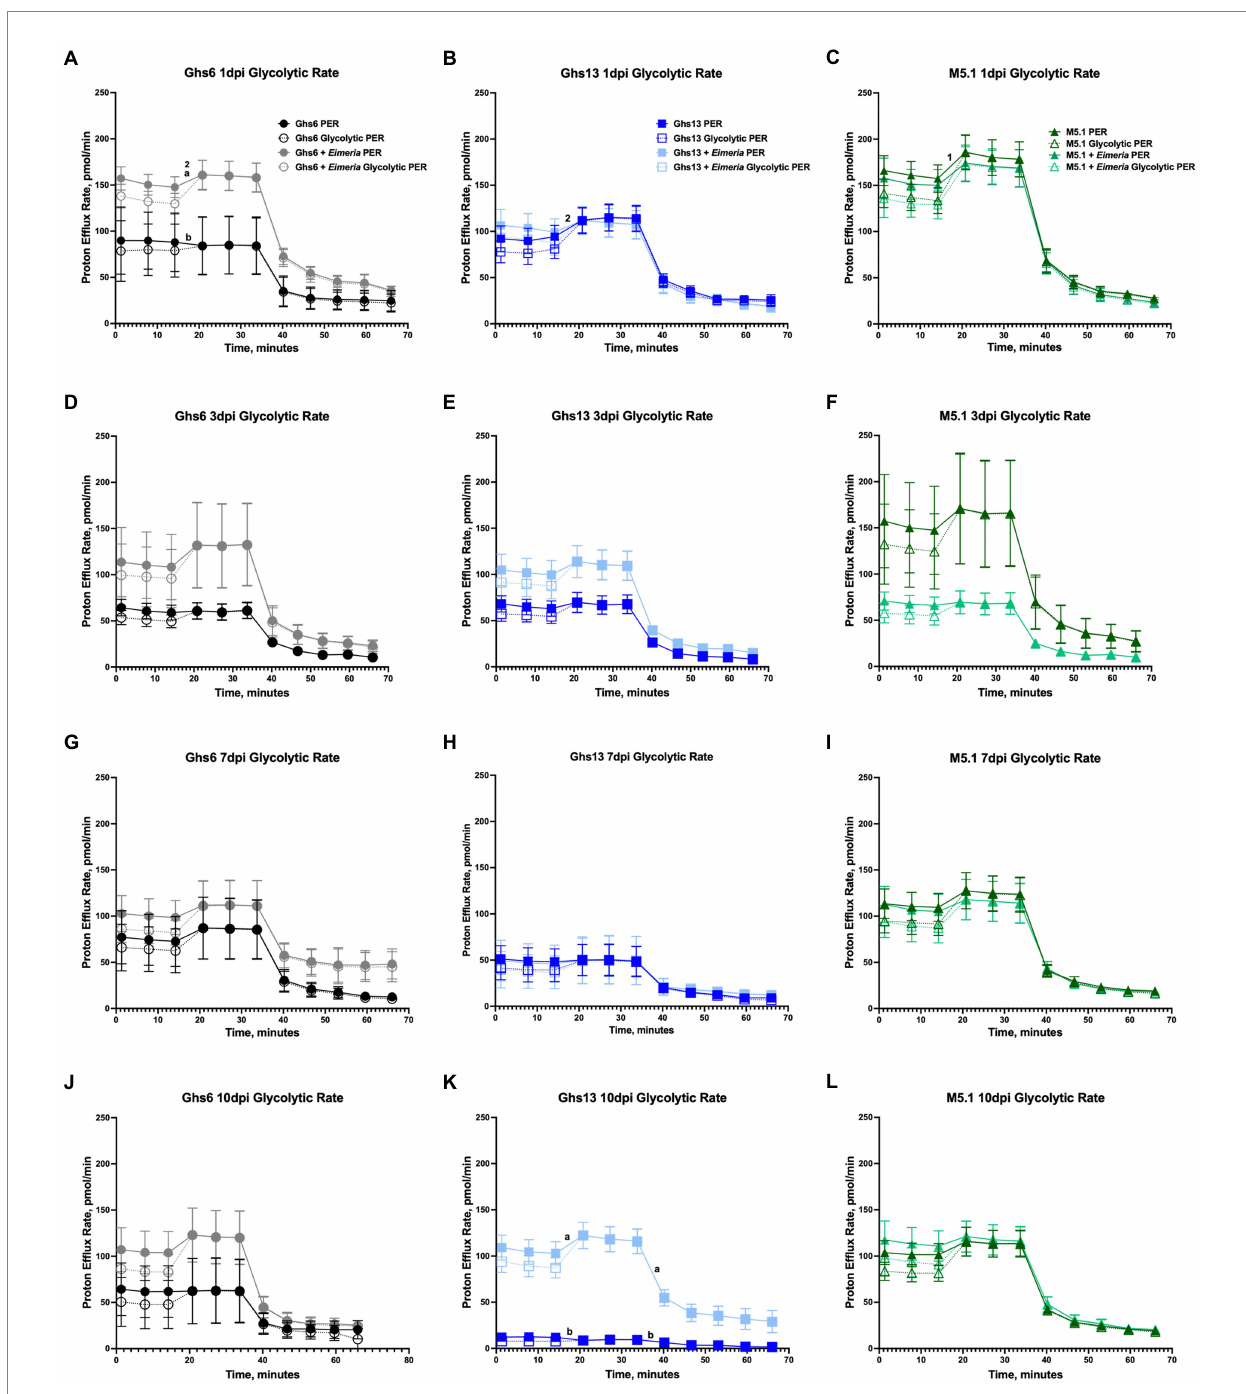
FIGURE 3 Glycolytic rate assay outputs in peripheral blood mononuclear cells isolated from Leghorn (A,D,G,J) Ghs6 and (B,E,H,K) Ghs13 and (C,F,I,L) Fayoumi M5.1 inbred genetic lines at (A–C) 1, (D–F) 3, (G–I) 7, and (J–L) 10 day post-inoculation (pi) with 10X Coccivac-B52 (Merck Animal Health, Kenilworth, NJ) as determined by the Agilent Glycolytic Rate Assay and Seahorse XFe96 analyzer (Santa Clara, CA). Data represent the mean proton efflux measurement (PER; n = 5 birds/treatment) ± SEM. Slopes between panels within the same timepoint labeled with a different number indicate a significant genetic line main effect while slopes with different letter labels within the same panel and timepoint denote a significant line × Eimeria effect ( p ≤